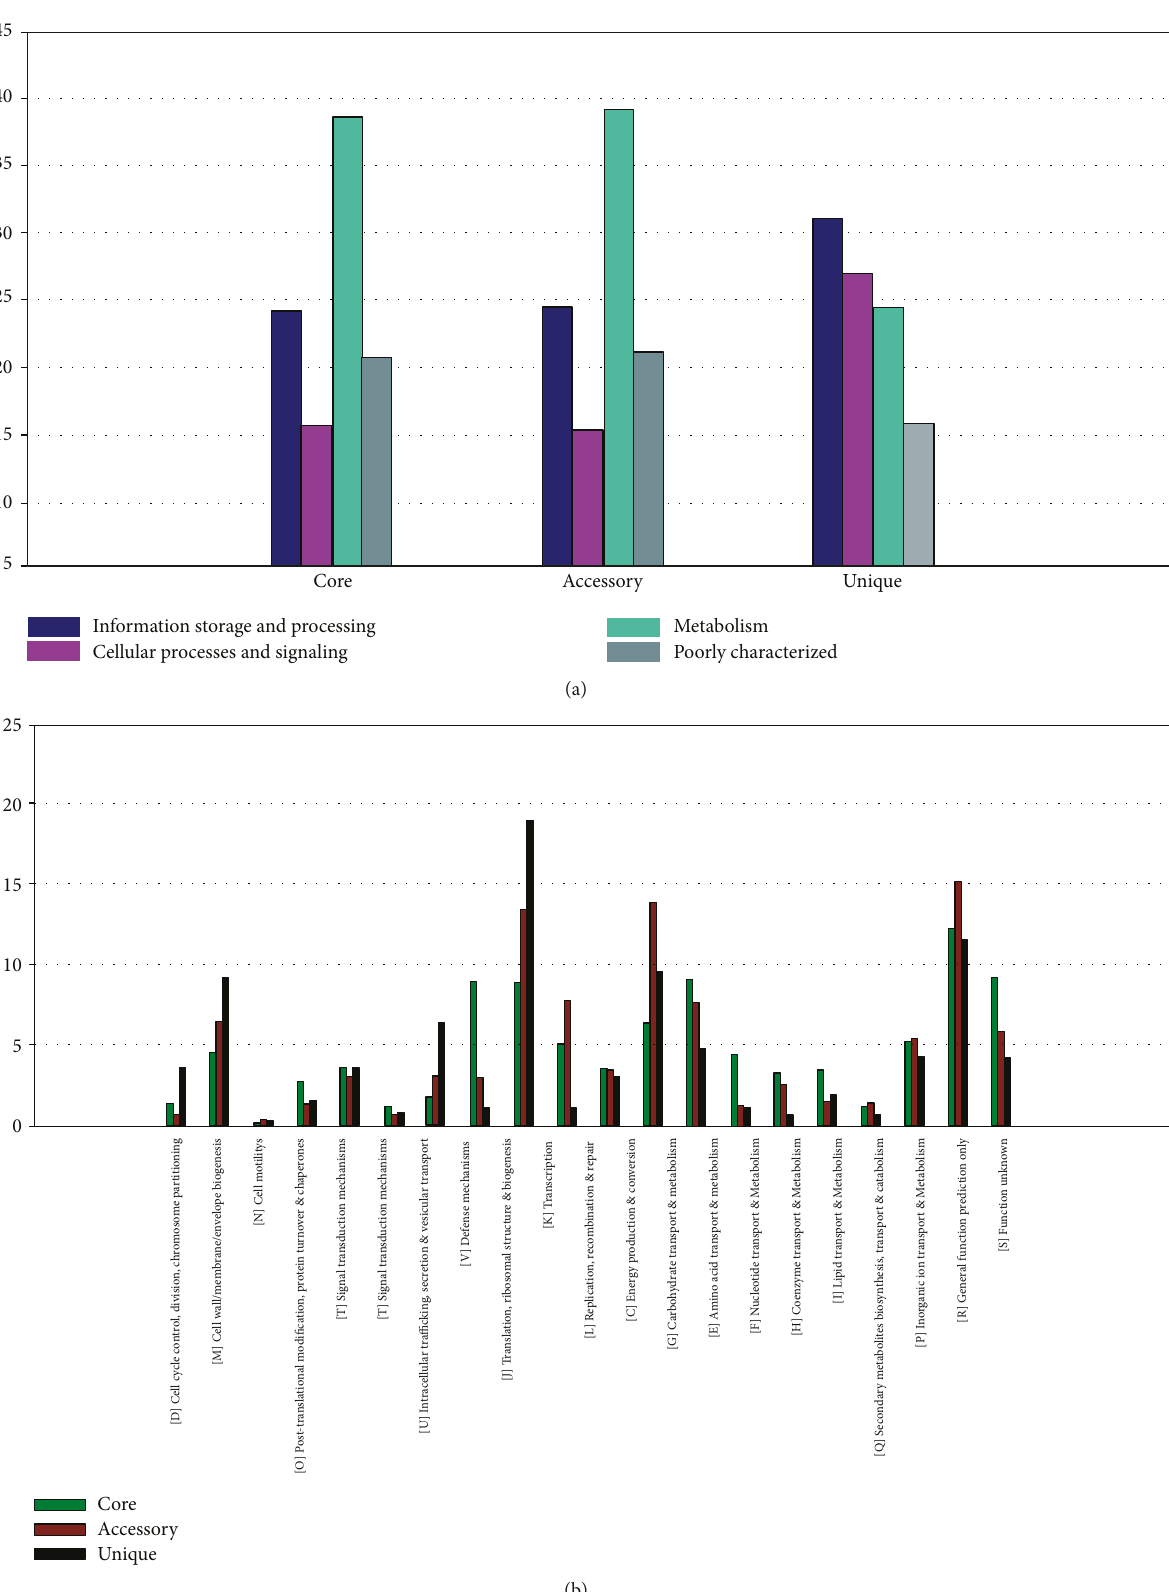
Figure 2: Pan-genome prediction. (a) core, accessory and unique genes into the functional standard of the COG; (b) the speci fi c distribution of the genes into 20 COG